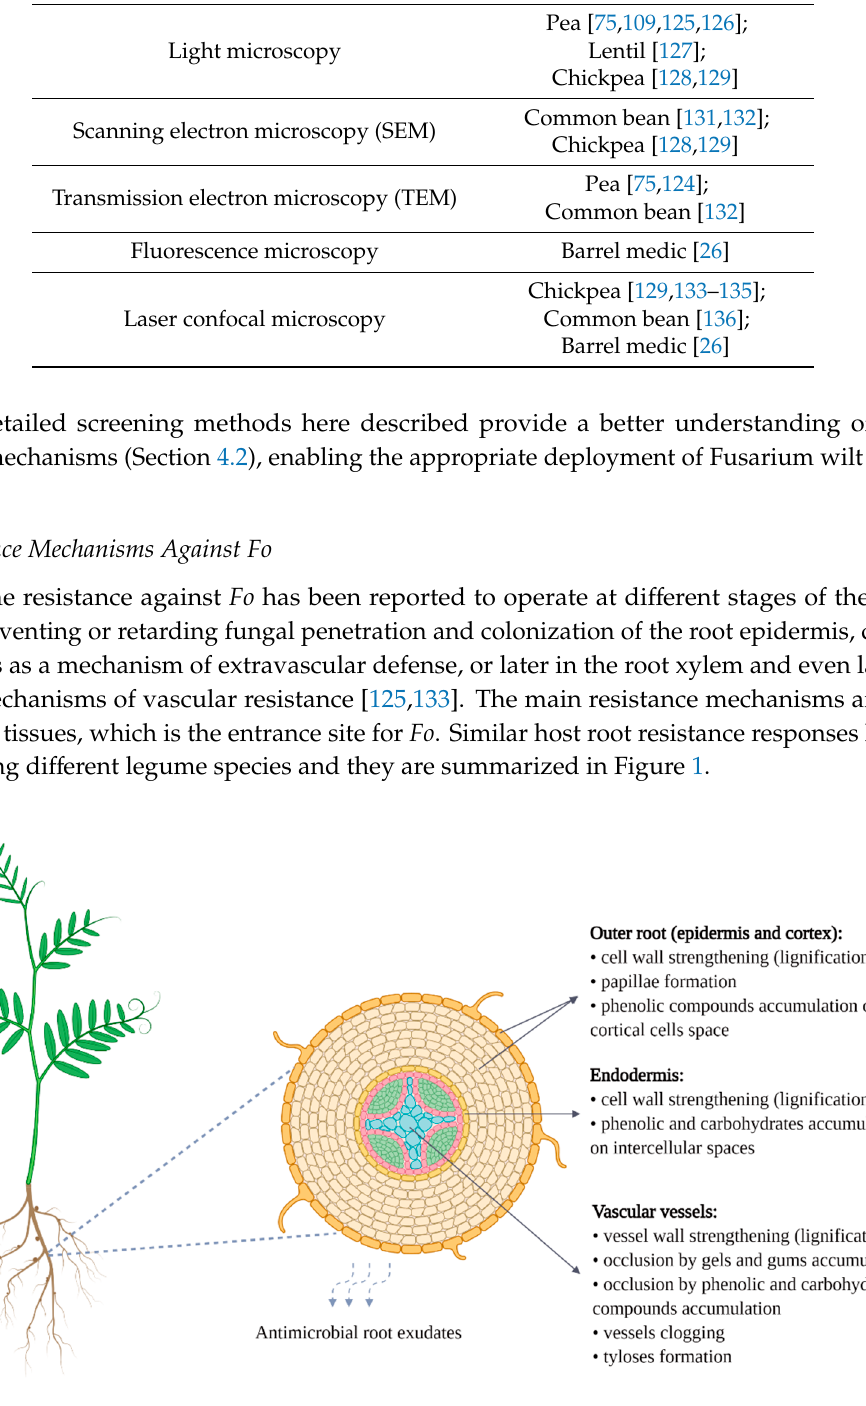
Figure 1. Legumes’ common root resistance mechanisms against Fusarium wilt (schematic representation made in ©BioRender—biorender.com).